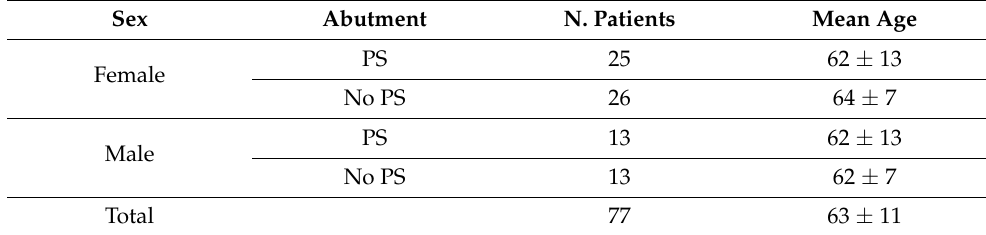
Table 2. Implant distribution considering sex and